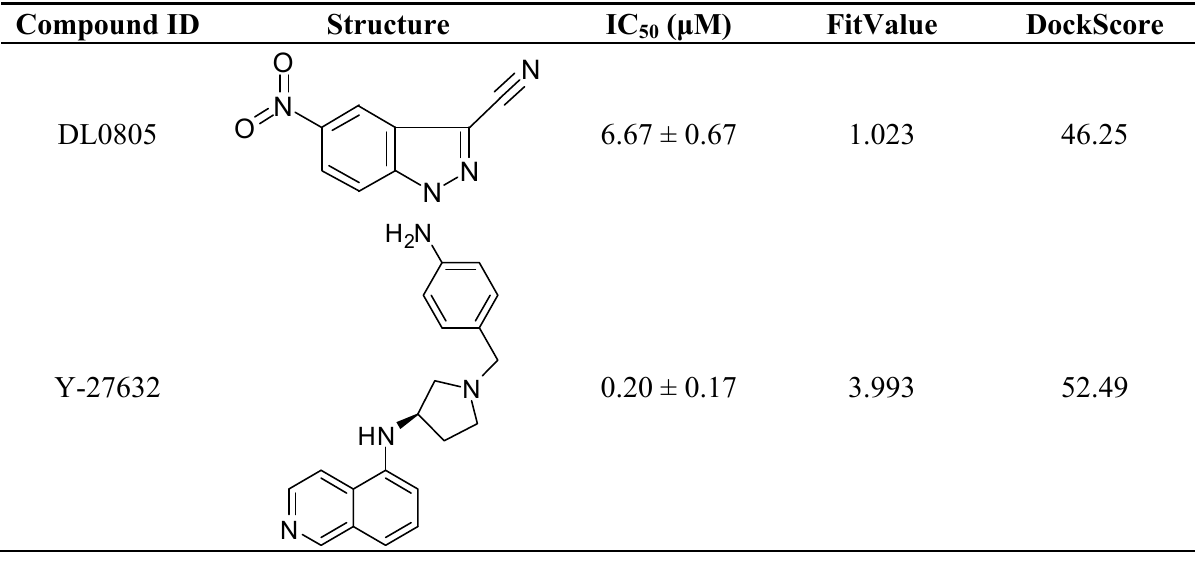
values for DL0805 and 50